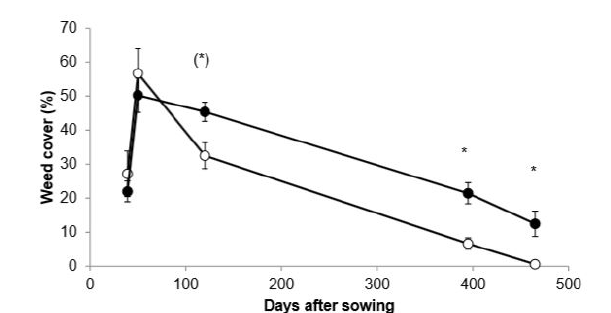
Figure 2. Development of estimated weed cover (%) over time in a complex species mixture of grasses and